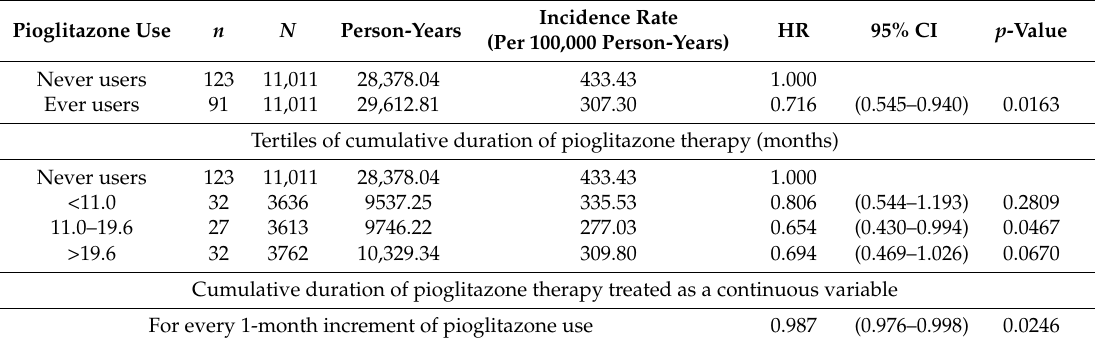
Table 2. Incidence rates and hazard ratios of dementia by pioglitazone exposure.